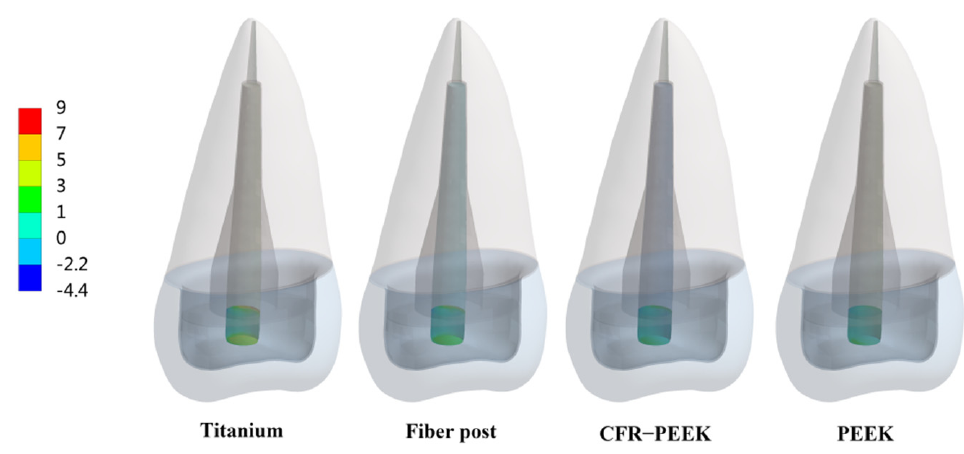
Figure 11. Distributions of MPS at post-core interface in prototype 2. From the perspective of strain in Prototypes 2 and 3 (Table 2), the strain of titanium restoration, fiber post restoration and CFR-PEEK restoration were all smaller than the corresponding root strain, but the absolute value of strain difference of the CFR-PEEK post was the smallest. The strain of the pure PEEK post itself was the largest, even larger than that of the root, and the absolute value of the strain difference was also higher than that of the CFR-PEEK post both in Prototype 2 and Prototype 3. Table 2. Strain of root and